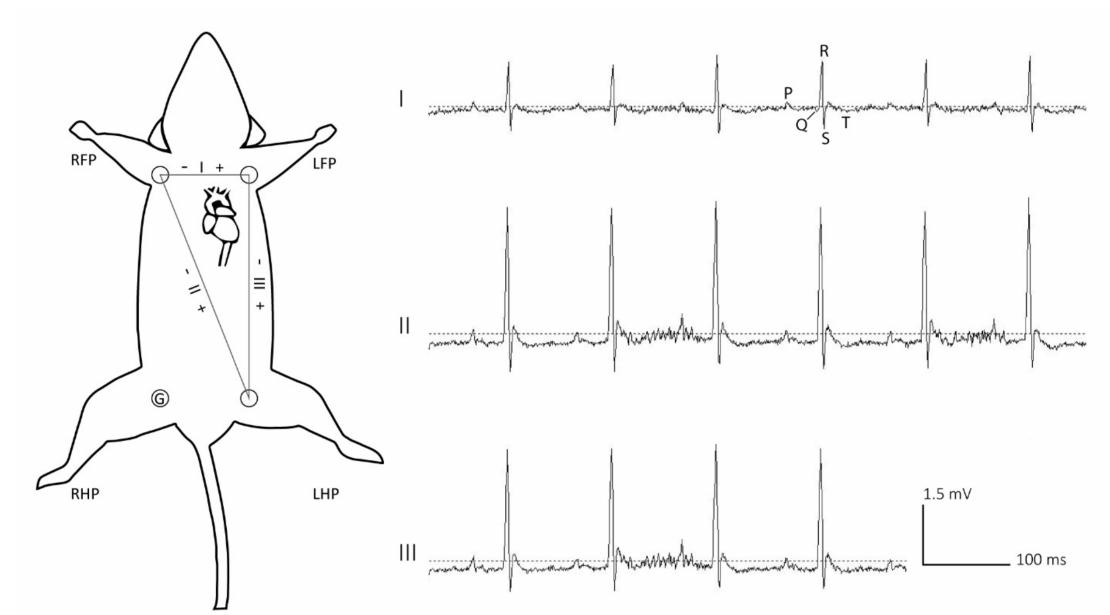
Figure 2. Mouse in supine position with schematic representation of the obtained lead configuration (lead I, lead II and lead III) with representative ECG-traces. P-wave, QRS complex, and T-wave are annotated on the ECG-trace in lead I configuration. Vertical and horizontal scale bars represent 1.5 mV and 100 ms, respectively. G; ground, RFP; right front paw, LFP; left front paw, RHP; right hind paw, LHP; left hind